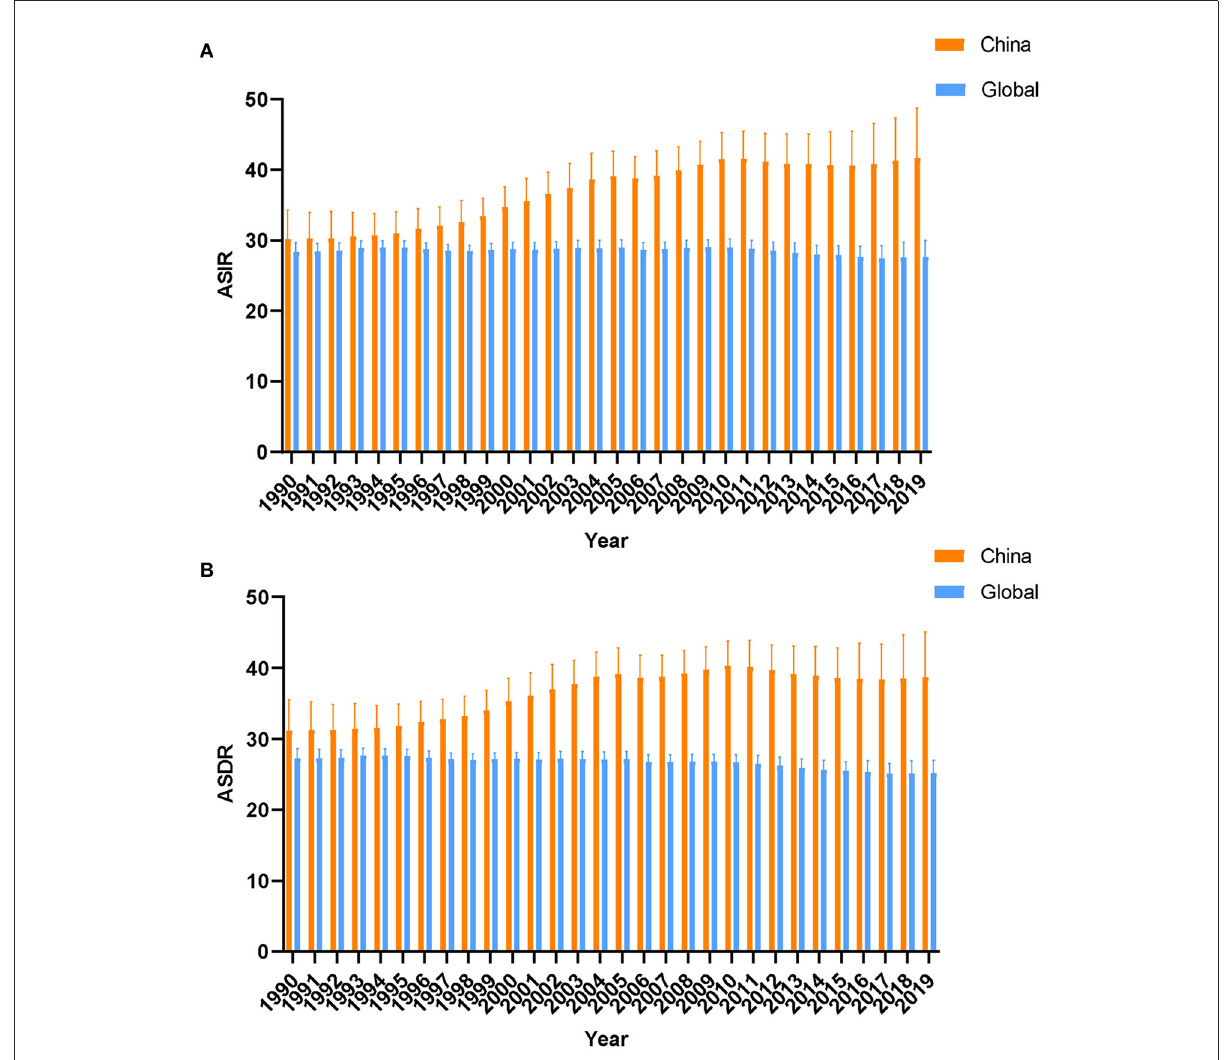
FIGURE1 The trends of age-standard incidence rates (A) death rates (B) of lung cancer in global and China from 1990 to